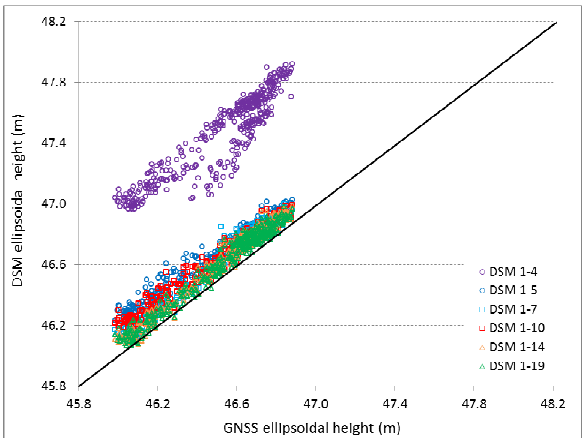
Figure 8. Scatter plot of profiles ellipsoidal height Plotting the vertical discrepancy depending on the number of GCPs, a decreasing curve is obtained with RMSD stabilization at 9 cm for 14 GCPs (Figure 9). Goldstein et al. (2015) found the same type of relationship with a kite at 20 m above a gently sandy beach. This curve stabilization shows that from a GCP number, increasing the number of GCP does not allow increasing the vertical accuracy.